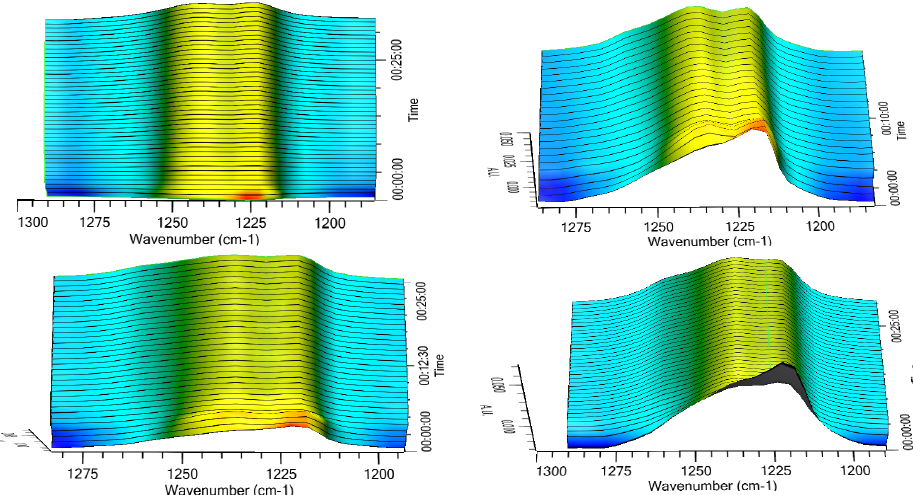
Figure 6. Expansion in the range 1300–1190 cm − 1 of the 3D IR spectra of rifaximin α form exposed to environmental humidity ( upper left ), 70% RH ( upper right ), 75% RH ( lower left ), and 95% RH ( lower right ) evidencing the diagnostic peak of the α form (1227 cm − 1 ) and β form (about 1223 and 1241 cm − 1 ).